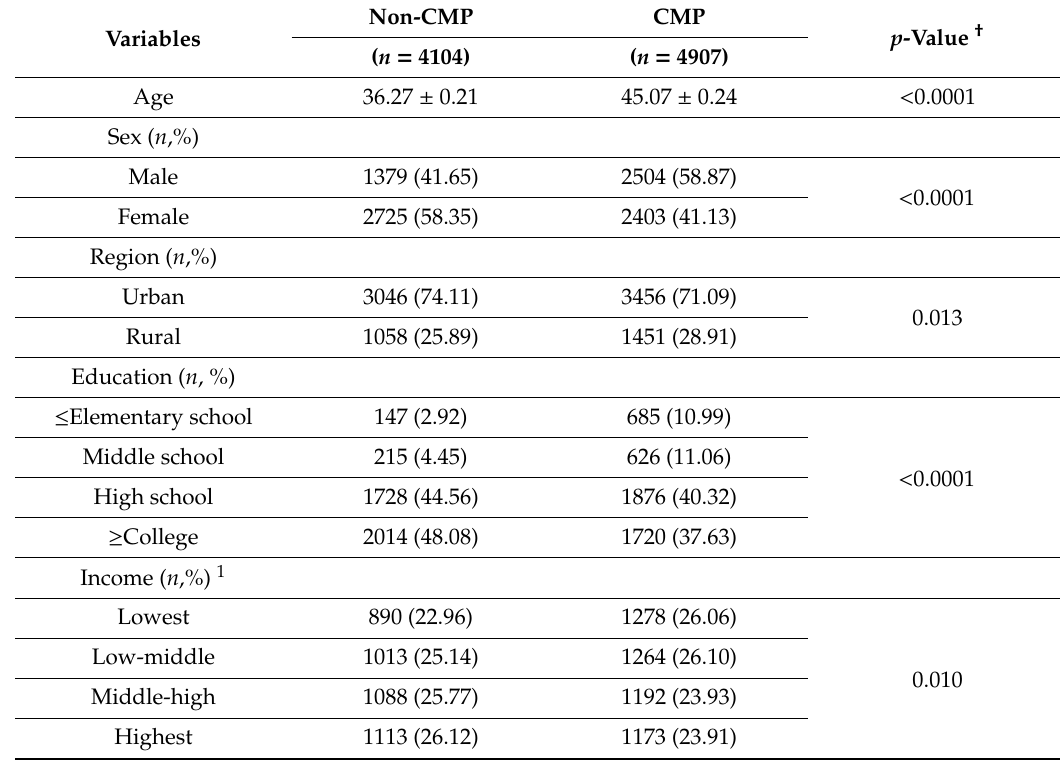
Table 1. Sociodemographic characteristics and health-related behaviors of adults aged from 19 to 64 years in South Korea according to CMP (KNHANES VI 2013–2015)